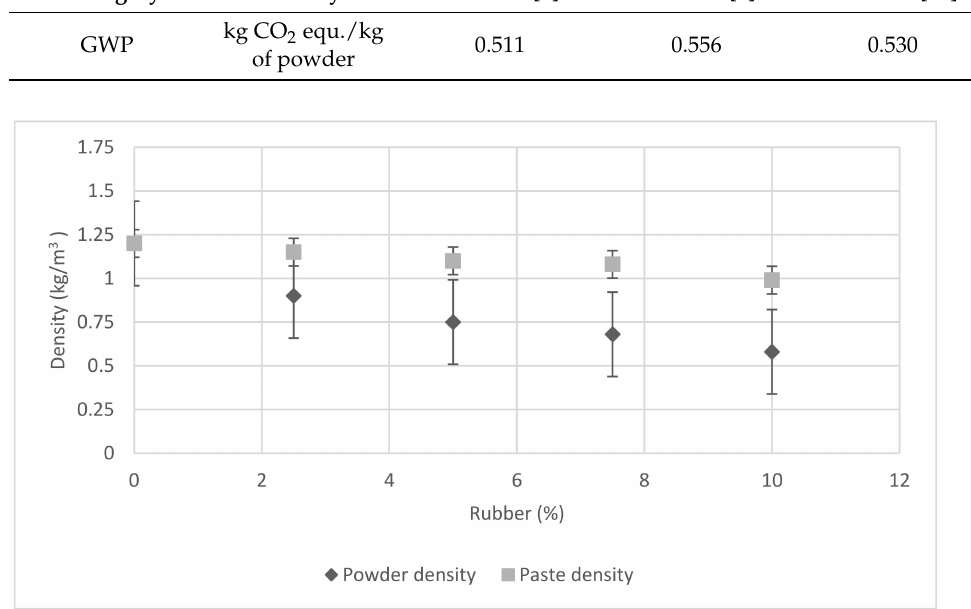
Figure 1. Powder and paste density of a C2S tile adhesive as a function of recycled rubber